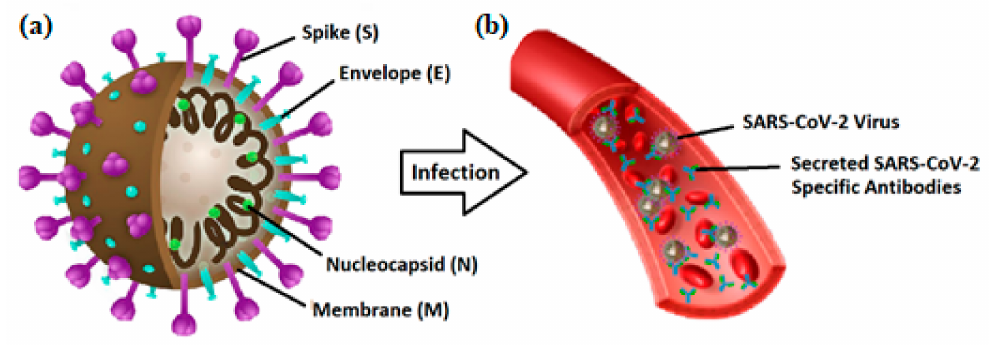
Figure 2. Schematic view of ( a ) SARS-CoV-2 virus and its structural proteins; ( b ) infection by SARS-CoV-2 and secretion of specific antibodies in the